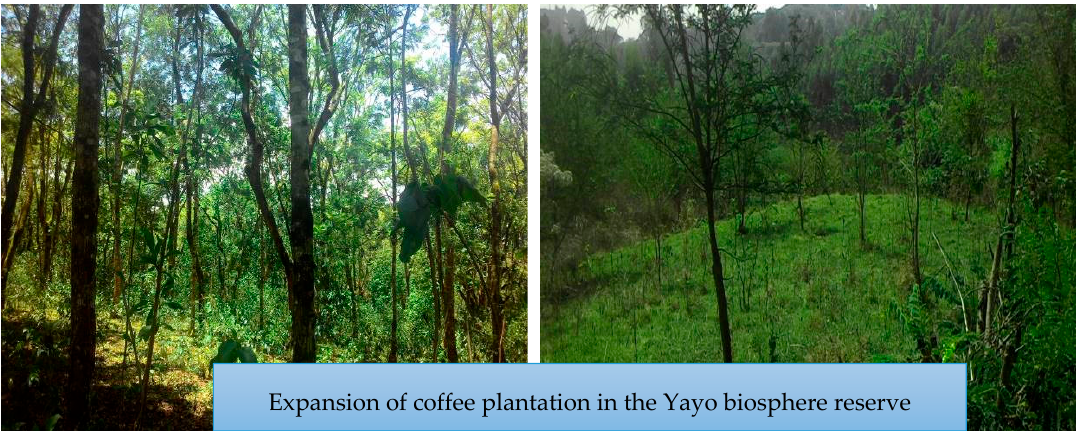
Figure 3. Photographs illustrating expanding trends of coffee plantation in the Yayo BR, photo taken by the author, March 2017.